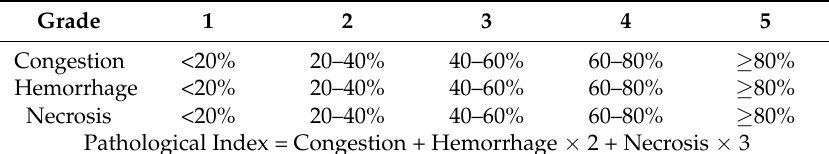
Table 2. Scoring criteria for pathological index.